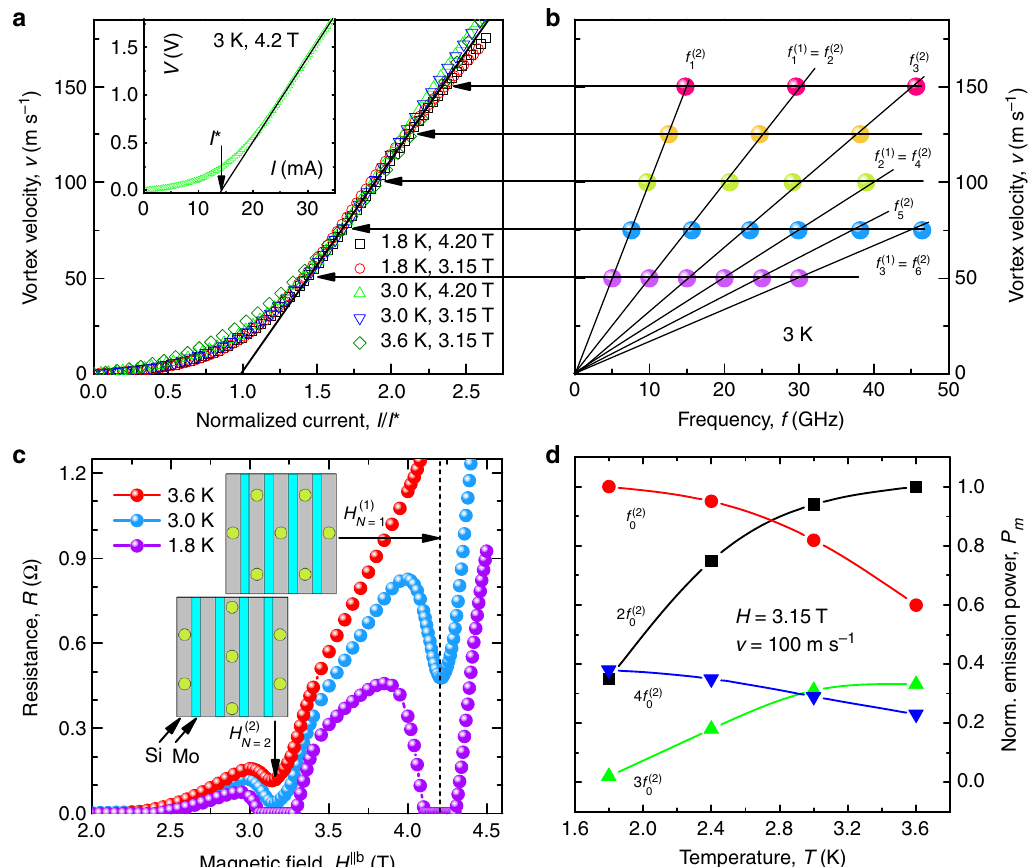
Fig. 3 Emission frequencies and vortex lattice con fi gurations at matching fi elds. a I – V curves in the vortex velocity versus normalized current representation. The horizontal arrows indicate the vortex velocities at which the emission spectra in Fig. 2 have been acquired. Inset: The I – V curve of the sample at 3 K and 4.2 T. The vertical arrow indicates the de fi nition of I * used for plotting the I – V curves in the main panel. b Peak frequencies versus vortex velocity for the data sets ( c , d ) of Fig. 2. c Resistance as a function of H || b for a series of temperatures, as indicated. The vortex lattice con fi gurations, which ¼ 3 : 15 T and H ð 1 Þ ¼ 4 : 2 T, are shown in the scaled coordinate system ( γ a , c ) in the inset. d Normalized commensurate with the Mo/Si superlattice at H ð 2 Þ N ¼ N ¼ 1 2 ¼ 10 : 02 GHz emitted at the vortex velocity v = 100 m s − 1 at emission power P m as a function of temperature for the fi rst four lowest-order harmonics f ð 2 Þ 0 3.15 T. Solid lines are guides for the